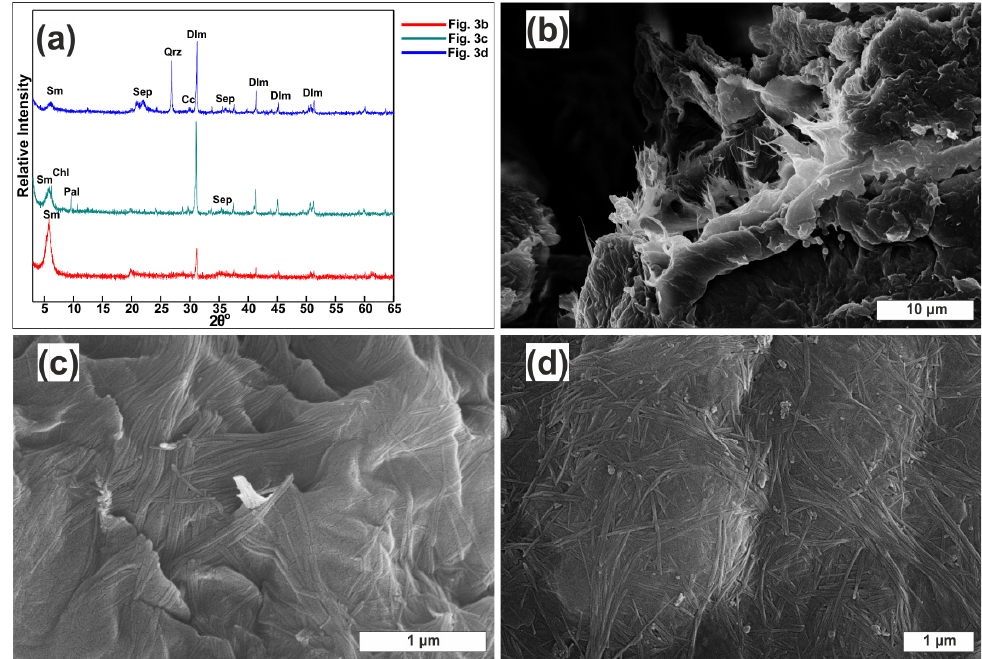
Figure 3. ( a ) XRD patterns of the samples referred in Figure 2f; ( b ) typical layered smectite structure altering into fibrous clay minerals within completely altered peridotite; ( c ) palygorskite fibers cov- ering phyllosilicate minerals within completely altered green-colored peridotite; ( d ) typical fibrous morphology of sepiolite within vuggy listwaenite. Abbreviations: Sm = smectite; Sep = sepiolite; Cc = calcite; Dlm = dolomite; Chl = chlorite; Pal = palygorskite.